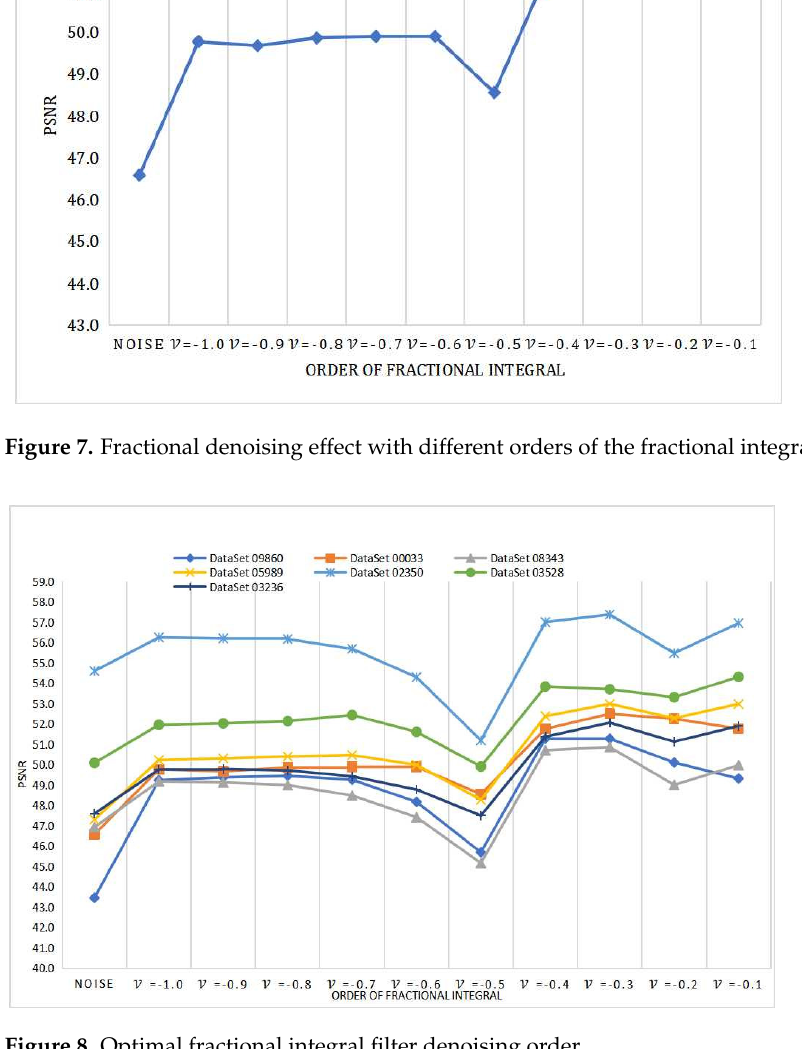
Redwood dataset [20] were each used for fractional filter denoising. The filter order range was − 1.0 ≤ ν ≤ − 0.1, as shown in Figure 9; the best denoising effect of the fractional order was achieved when − 0.4 ≤ ν ≤ −